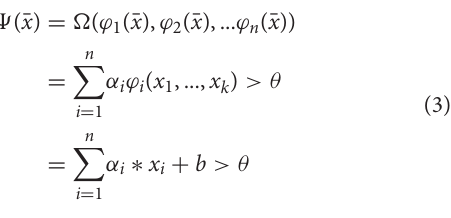
{ 0, ..., n − 1 } . Strictly speaking, this definition differs from the definition first proposed by Minsky and Rosenblatt where the function spaces are of the form { 0, ..., n − 1 } k → { 0, 1 } , which are binary